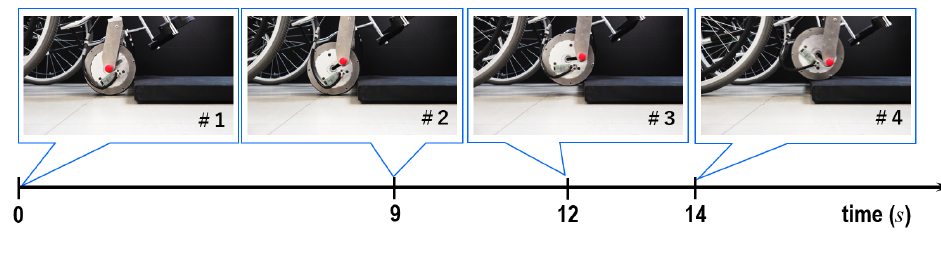
Figure 16. Experimental scene for step-ascending mode using the proposed wheel prototype (case-4) where the horizontal direction indicates time over the step-ascending motion.